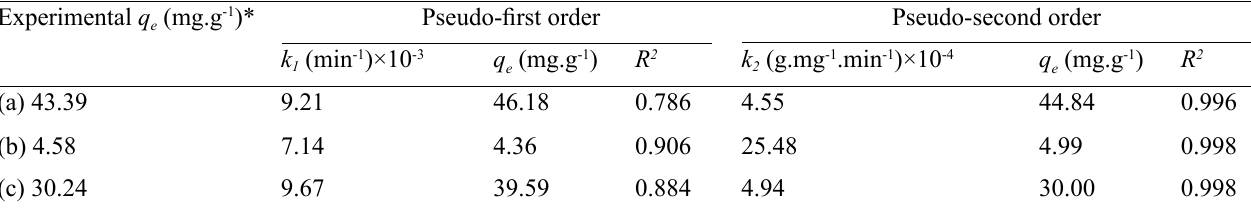
Table 6. Kinetic parameters for the adsorption of Th(IV) onto ion exchange resins.